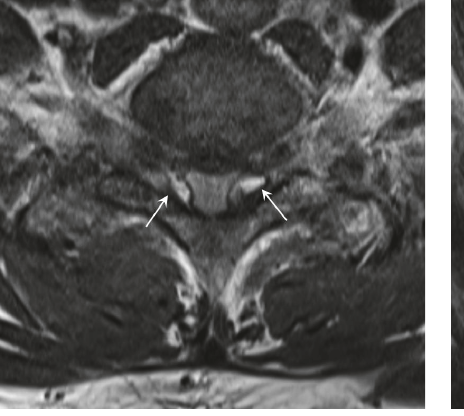
Figure 1: Magnetic resonance imaging (MRI) findings of bilateral ganglion cysts of the ligamentum flavum at